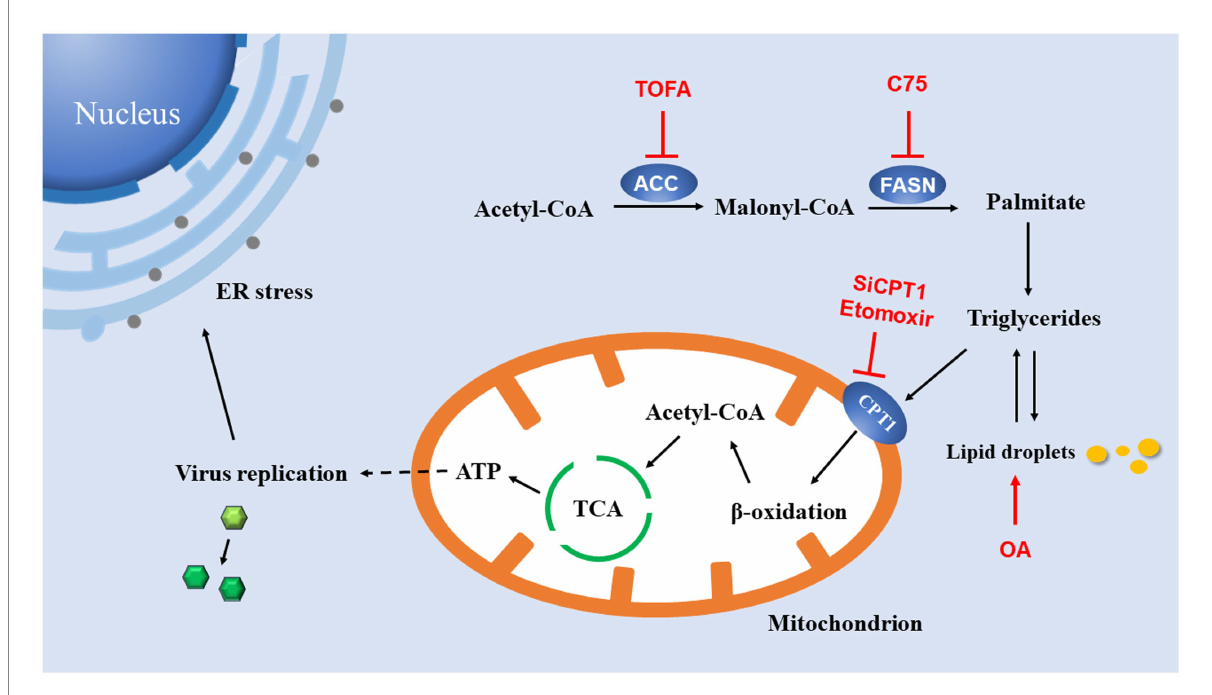
FIGURE 7 Model for lipid utilization during EV-A71 infection. The fatty acid biosynthesis pathway is used to generate ATP. Acetyl-CoA carboxylase (ACC) converts acetyl-CoA to malonyl-CoA; Fatty acid synthase (FASN) catalyzes the continuous condensation reaction of malonyl-CoA and acetyl-CoA to generate triglycerides. Triglycerides are then transported into mitochondria by carnitine palmitoyltransferase 1 (CPT1). In mitochondria, triglycerides undergo β -oxidation to acetyl-CoA, which drives the TCA cycle to generate ATP. ATP production supports DNA replication and protein synthesis of EV-A71. EV-A71 replication induces ER